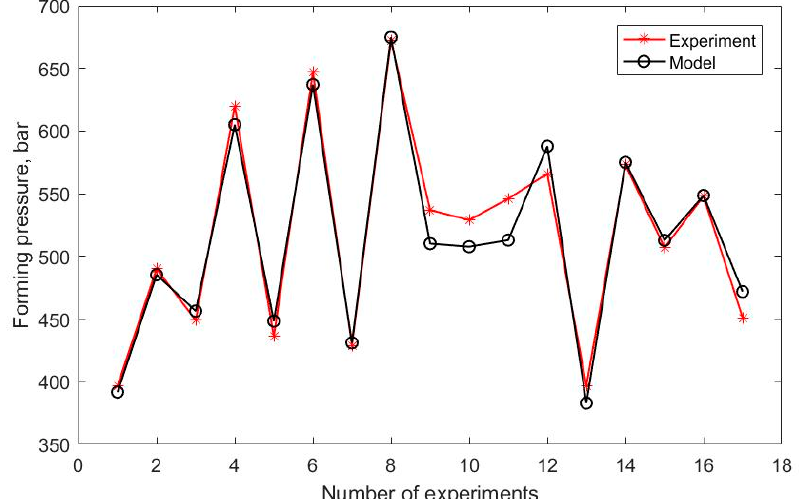
Figure 9. Comparison of modeled and experimental results.